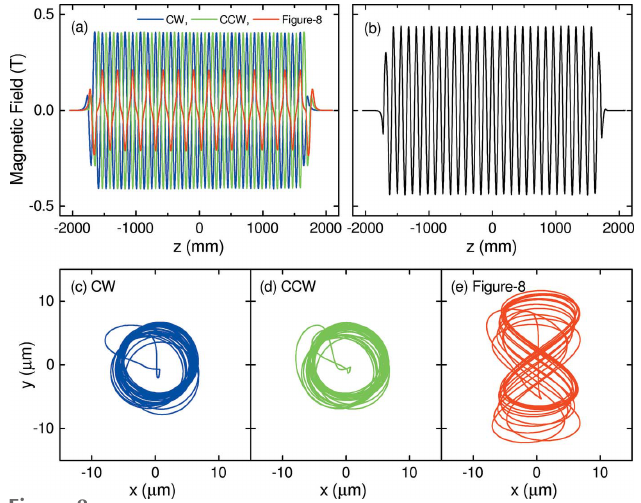
Figure 8 Results of the magnetic field measurement at the gap of 20 mm: ( a ) horizontal and ( b ) vertical field distributions, and ( c – e ) projections of electron trajectories (second field integral) evaluated for the three operation modes.